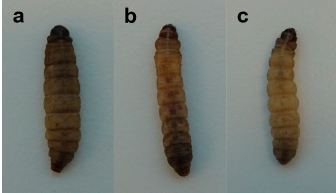
Figure 4. Larvae showing high melanization at day 6 post infection with Cryptococcus gattii strains CDCR265 ( a ) and DMST20767 ( b ), and little melanization of infected larva with CDCR272 ( c ). Histopathological findings of uninfected and infected larvae indicated that skeletal muscle damage and high cryptococcal cell numbers and spread within the organism are correlated with virulence (Figure 5a–j). The larvae infected with the high-virulence strains CDCR265 and DMST20767 showed skeletal muscle damage and large nodular lesions (Figure 5h–j), while the larvae infected with the low virulent strains CDCR272 shows little muscle damage and small nodular lesions (Figure 5c–g).